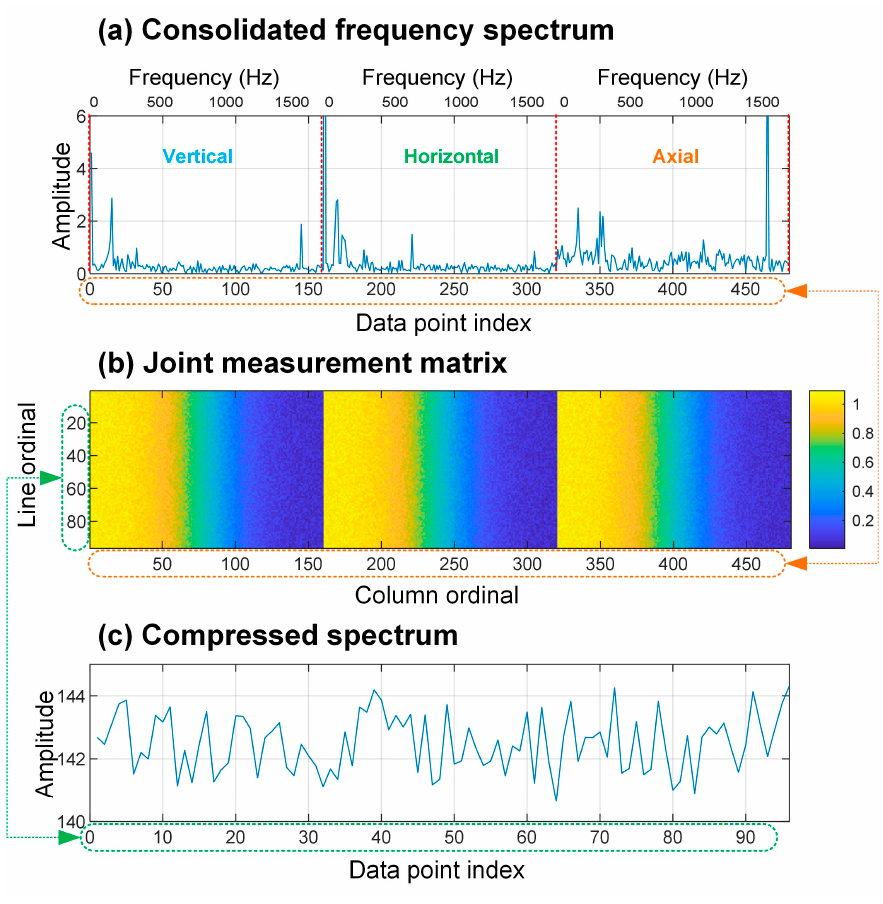
Figure 12. LGPG: compression of frequency spectra.